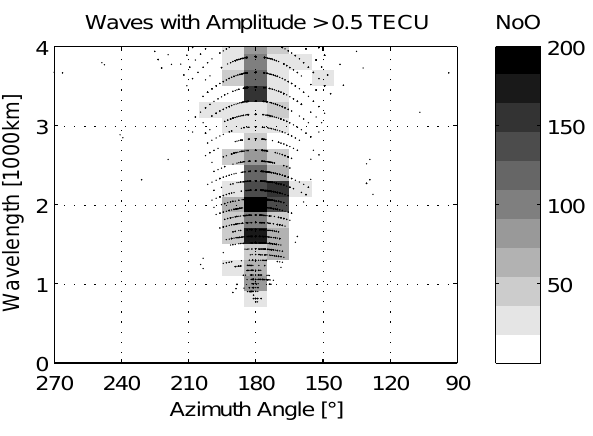
Fig. 4. Wavelength and direction of storm induced waves esti- mated from TEC perturbation maps in the first 12h after the storm starts. Each dot represents the result of a 2-D Fourier analysis on on TEC perturbation map. Only waves with amplitude higher than 0.5TECU are respected. The number of occurrence (NoO) per 10 ◦ /100km square is indicated with shadows.